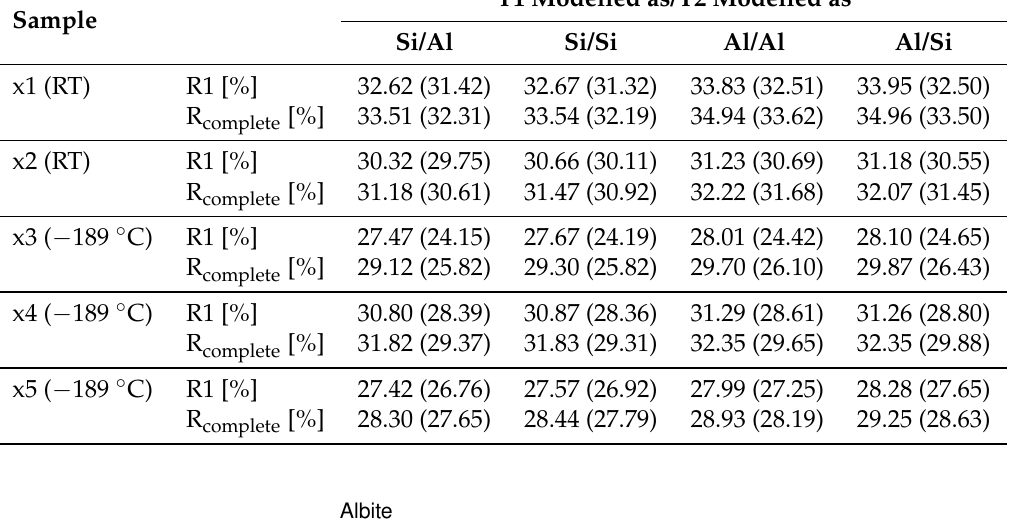
Table 2. R1 and R complete [35] values of zeolite A, measured at room temperature and − 189 ◦ C (as indicated). The second T-site is the aluminum site, i.e., the first column contains the correct combination Si/Al. All four possible combinations of modelling the two T sites as silicon and aluminum, respectively. Atom coordinates and one isotropic ADP value were refined for each atom site without restraints, and until convergence was reached (no parameter drift). Number in brackets calculated from strong reflections ( I / σ I > 2).